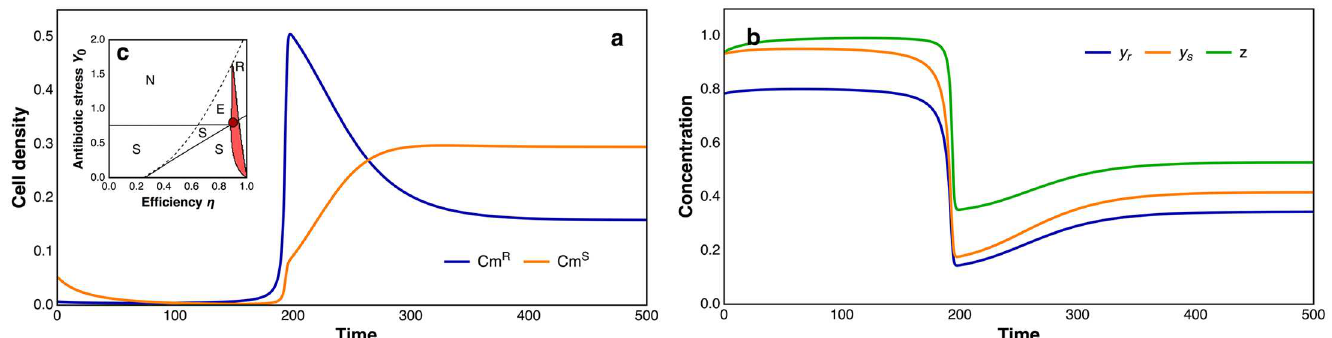
Fig 4. Population dynamics of bacterial communities. ( a ) Simulatedgrowth trajectories for Cm R and Cm S populationssubject to antibiotic stress and resourcecompetition. ( b ) Dynamic of intracellularCm ( y r and y s ) and growth-limiting resource ( z ). Simulation time is scaled relative to the mean residence time of cells in a chemostat, which is equal to the generationtime at steady state. At low population densities,the Cm R strain can grow, whereasCm S cannot, due to a high concentration of Cm. However, the invasionof Cm R lowers antibioticstress, generatingpermissiveconditions for the growth of Cm S cells. The chemostat is then rapidly colonizedby both strains (shortly after t = 180) until the resourcebecomes limiting.From that moment onwards,total cell density changeslittle, while the relativefrequenciesof the two strains continueto shift. Eventually, a stable equilibriumis reached, at which the cost and benefit of CAT expression(i.e., reducedgrowth rate efficiency for Cm R cells versus their lower intracellularCm concentration) balanceout. Inset ( c ), The dark-red dot pinpointsthe parameter set used in the simulationshown in a and b : r = 20.0, η = 0.9, k z = 4.0, c = 1.0, p = 50.0, h Y = 0.25/ Y 0 , k Y = 2.5/ Y 0 , d = 30.0/ Y 0 and Y 0 = 0.8. These parameters were selectedto lie in a restricted area of parameter space (highlightedin red) where stable coexistence betweenCm S and Cm R cells is observedAlternativemodel outcomes, which were identifiedby a numericalbifurcation analysis(see S1 Text and S4 Fig), includeestablishment of Cm S only (area S), establishment of Cm R only (area R), no bacterialgrowth (area N), and competition-induced extinction(area E, where Cm S bacteriafirst outcompeteCm R bacteria and subsequently are cleared by the antibiotic; see S5